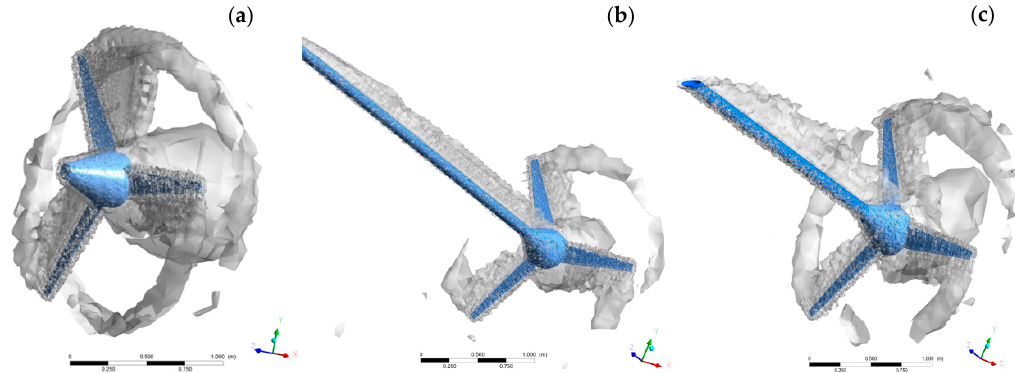
Figure 10. The vorticity isosurface of 1.5 Hz showing the detached boundary layer for the SP ( a ), SI15 ( b ), and SI30 ( c ) configurations from the turbine axis and the blades. The blade tip vortices are clearly visible.